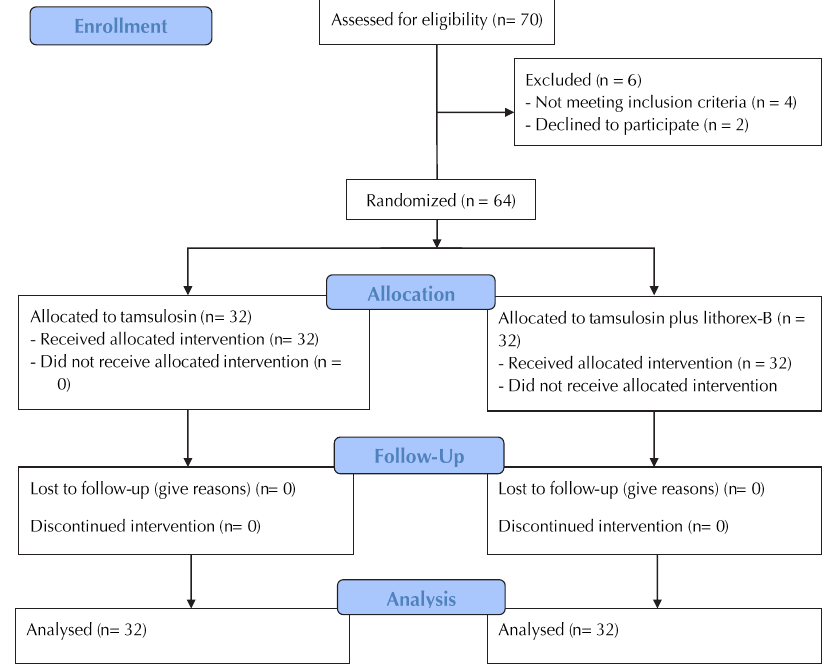
Figure 1. CONSORT statement flow diagram.